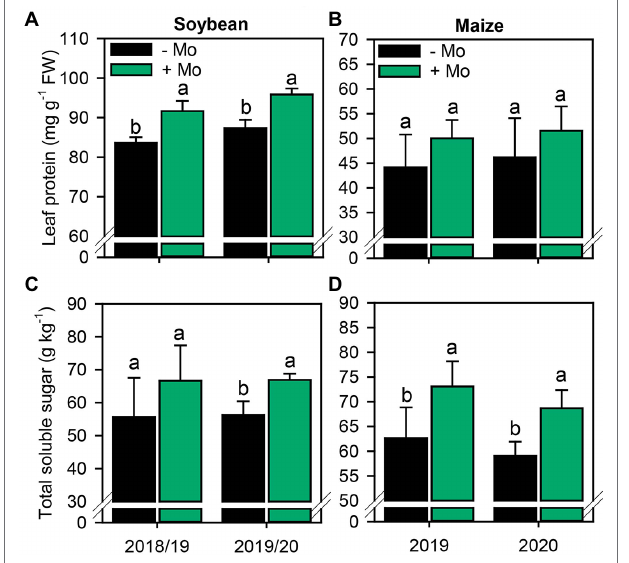
FIGURE 5 | Leaf protein and total sugar concentration in soybean (A,C) and maize (B,D) leaves as affected by foliar Mo fertilization. Different lowercase letters represent statistical difference between treatments (presence or absence of Mo) according to the F test ( p ≤ 0.10).